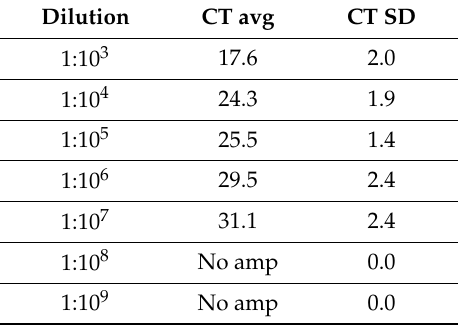
Table 3. ASBVd sensitivity test on Fluidigm BioMark Real-Time assay. Positive control samples were prepared by manual cutting. Dilution, CT average, and CT standard deviation are shown. “No amp” indicates no amplification.